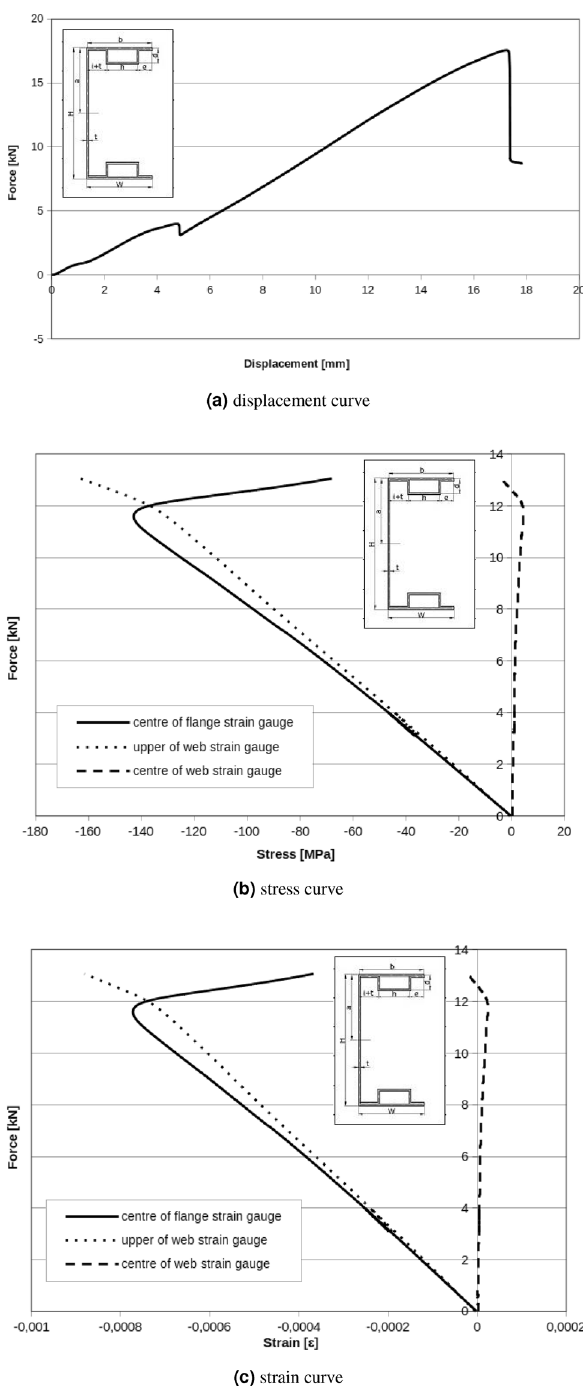
Figure 17. One box flanges without a reinforcement parts with